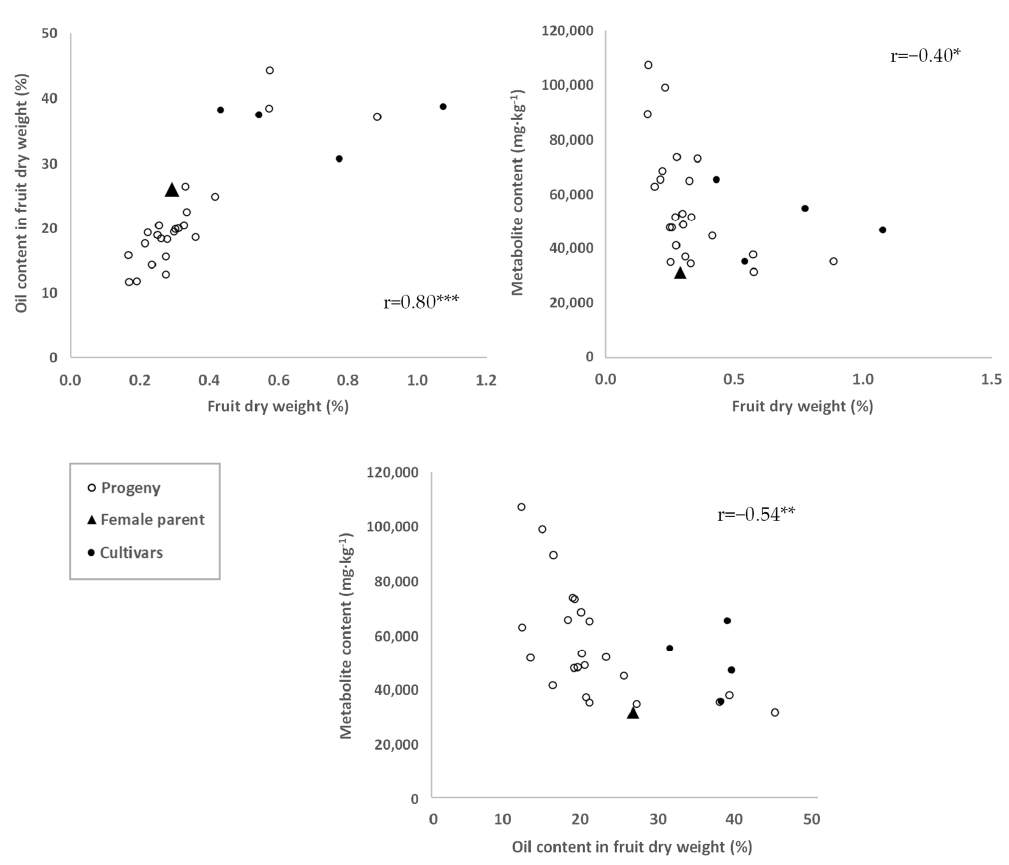
Figure 2. Evaluation of the relationships between fruit weight (g), oil content (%) and total metabo- lite content (mg ⋅ kg − 1 ). *, **, ***: significant at p < 0.05, 0.01, 0.001, respectively. content (mg · kg − 1 ). *, **, ***: significant at p < 0.05, 0.01, 0.001,